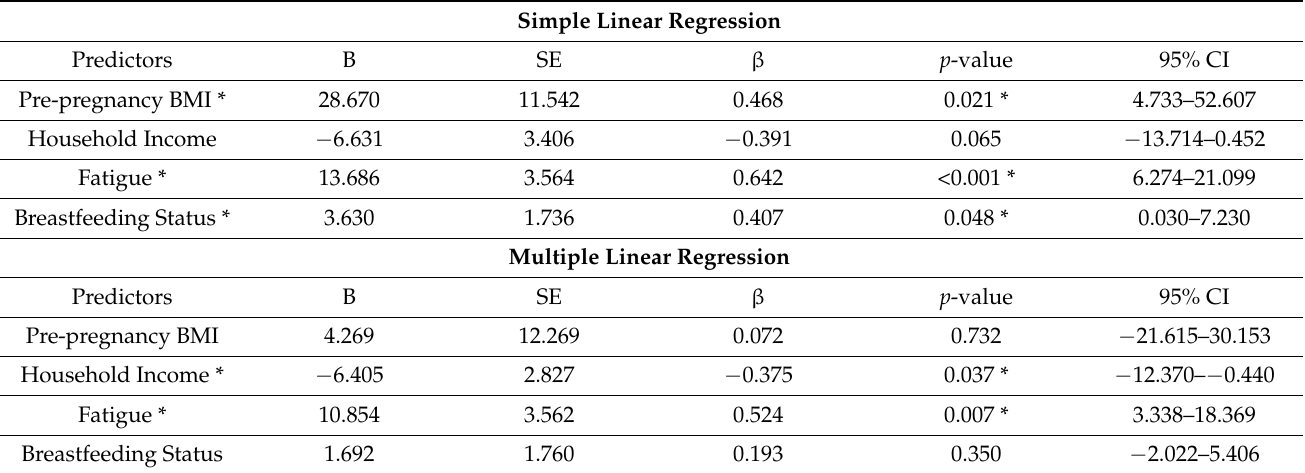
Table 3. Simple and Multiple Linear Regression.